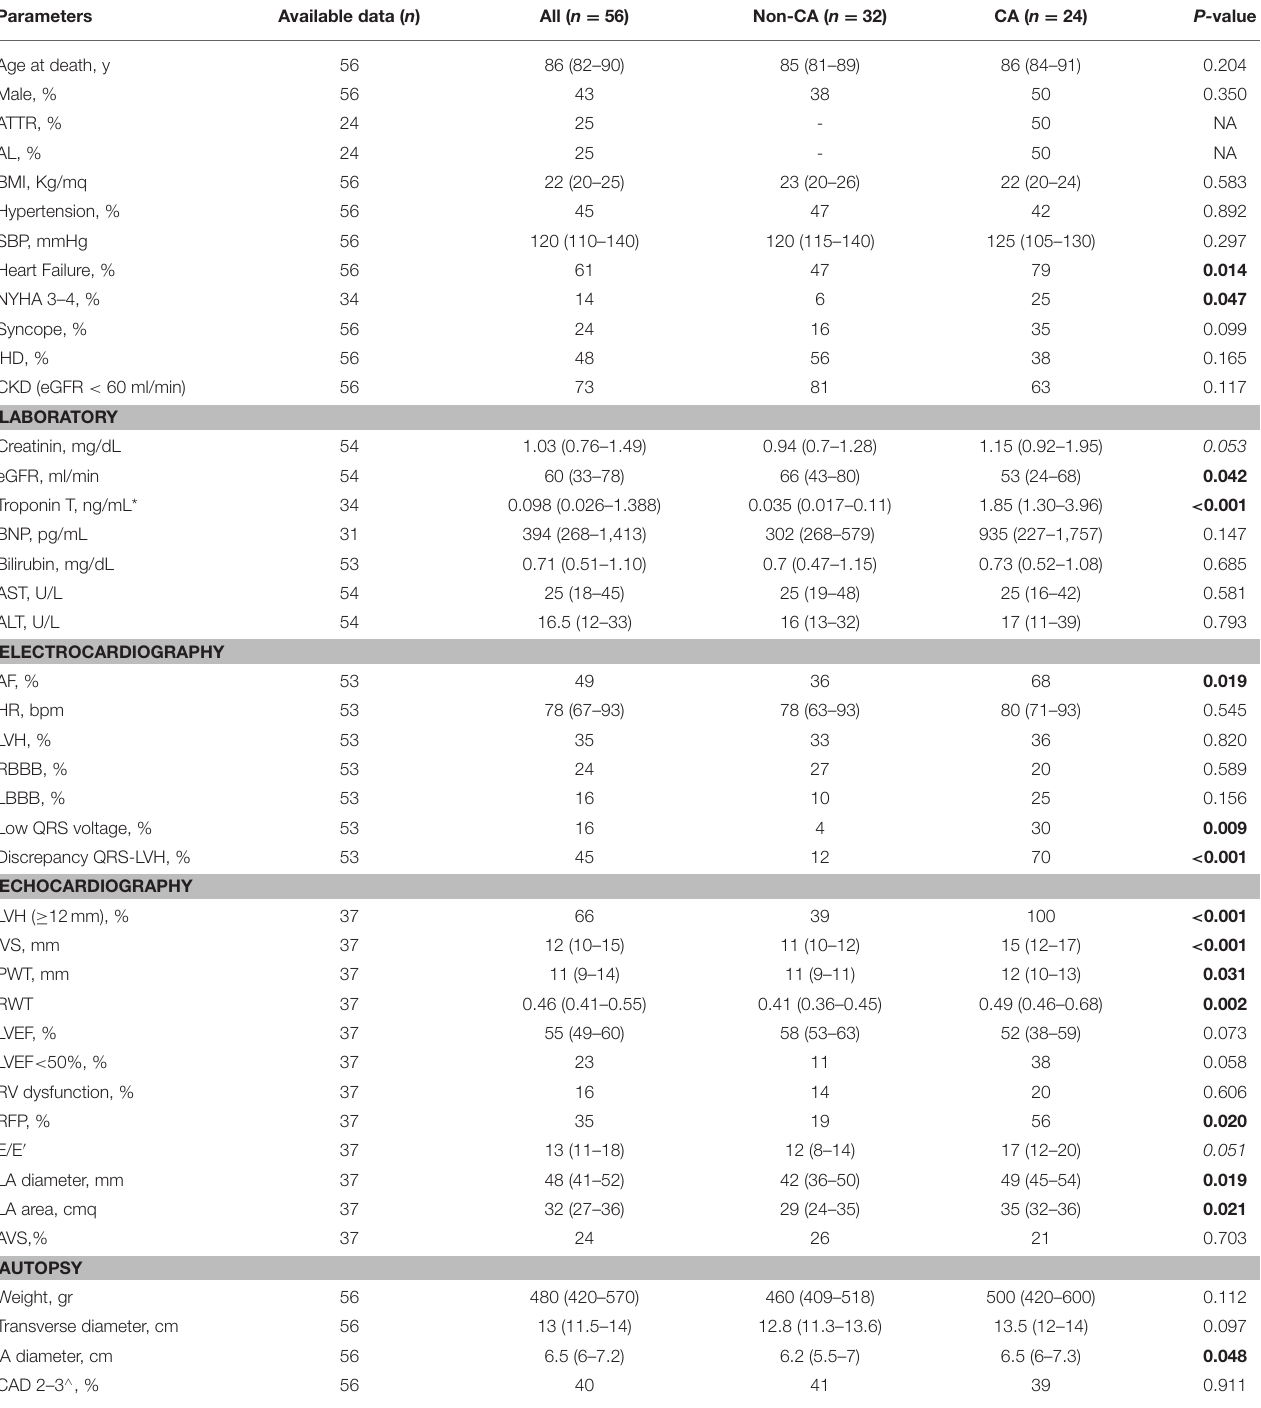
TABLE 1 | Characteristics of the study population based on histological evidence of CA.